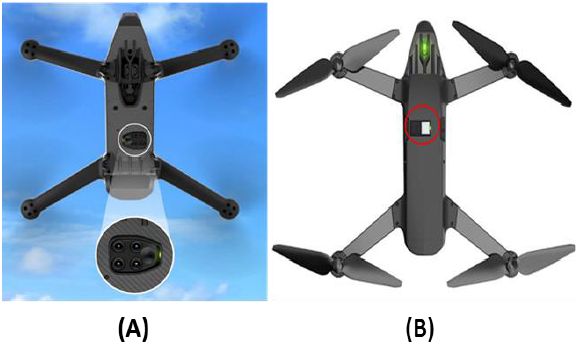
Figure 1. An illustration of the Parrot Bluegrass with (A) the Sequoia camera visible underneath and (B) the sunshine sensor visible in a top-down